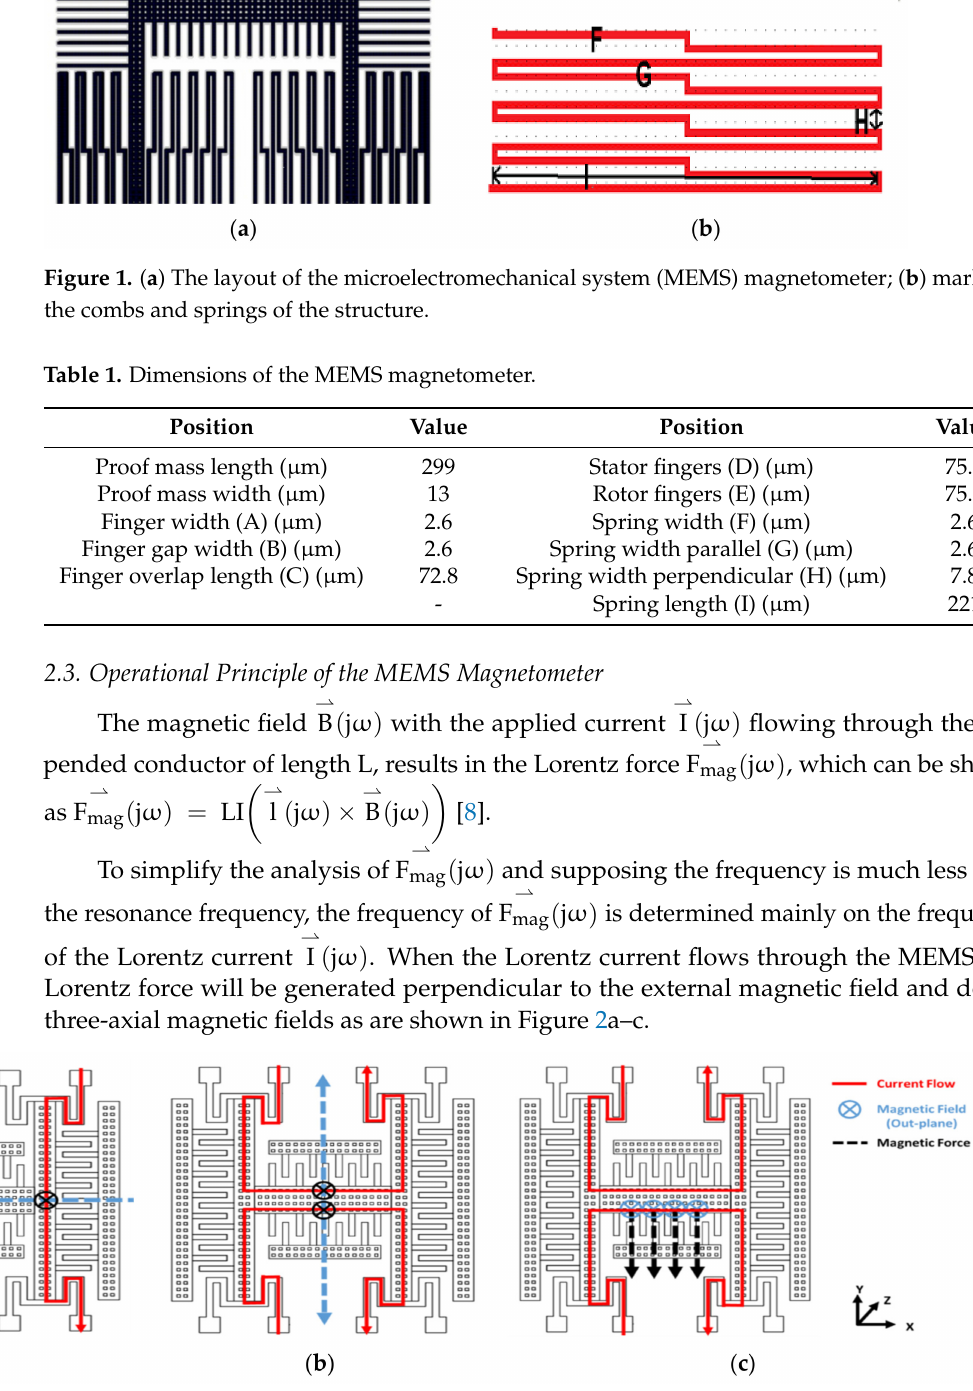
Figure 2. ( a ) Schematic of the sensing X -axis magnetic field; ( b ) schematic of the sensing Y -axis magnetic field; ( c ) schematic of the sensing Z -axis magnetic